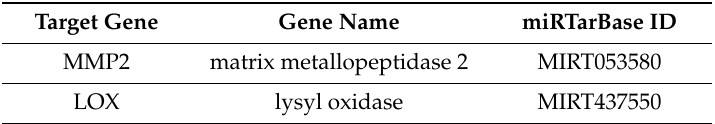
Table 1. Validated target genes with high score interaction linked to keratinocytes homeostasis for hsa-miR-29a-3p according to the miR target link